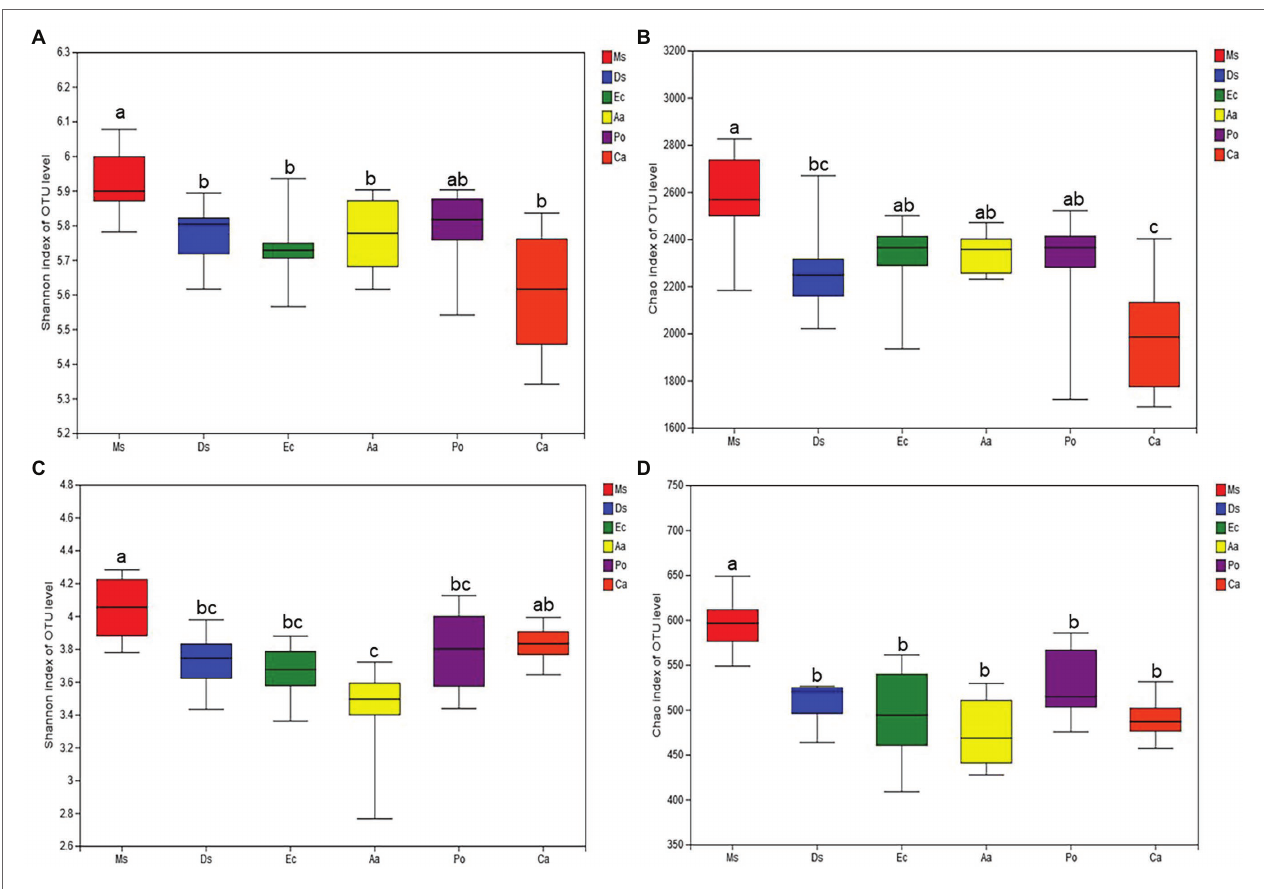
FIGURE 3 | Diversity indices (Shannon and Chao 1) of soil bacterial (A and B) and fungal (C and D) communities in the six plant soil samples. All data are presented as the mean ± SD. * p < 0.05 and ** p < 0.01 based on Tukey’s pairwise